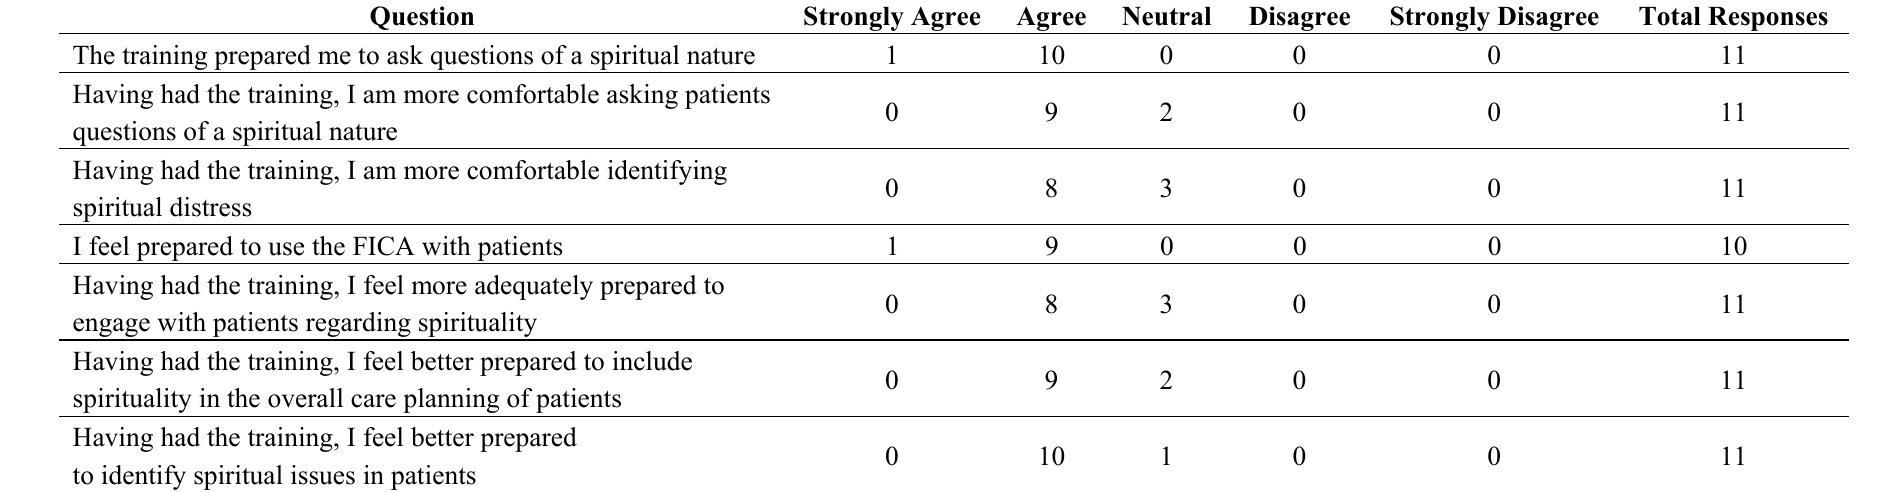
Table 3. Healthcare professionals preparedness to include spirituality in patient care